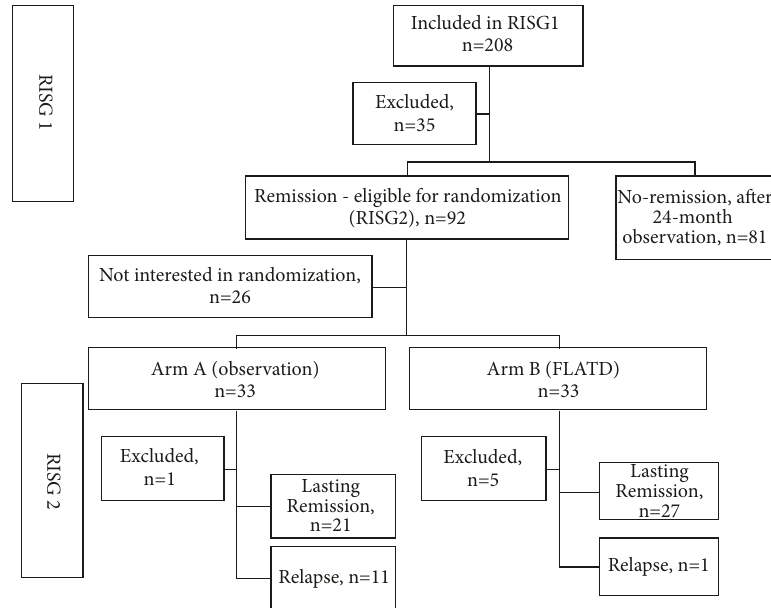
Figure 1: Flow chart of the inclusion process comprising the two substudies RISG1 (predictor of attaining remission) and RISG2 (comparing relapse rates in patients randomized to observation or fixed low dose antithyroid drug treatment;